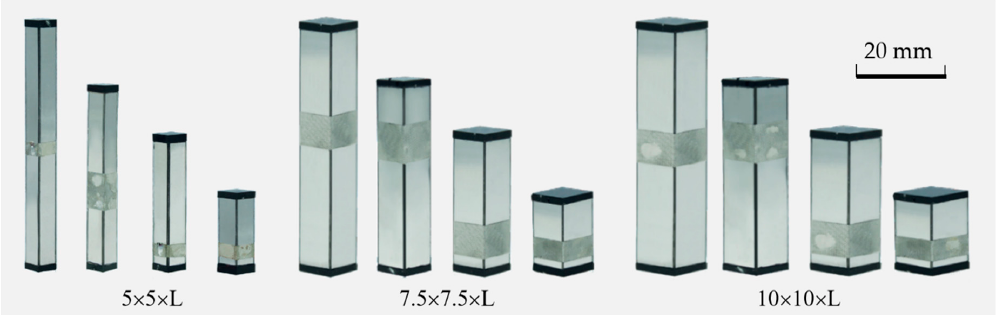
Figure 2. Pictures of a range of stake actuators fabricated. L = 15, 28, 41 and 54 mm. Crystal thickness = 0.4 mm.